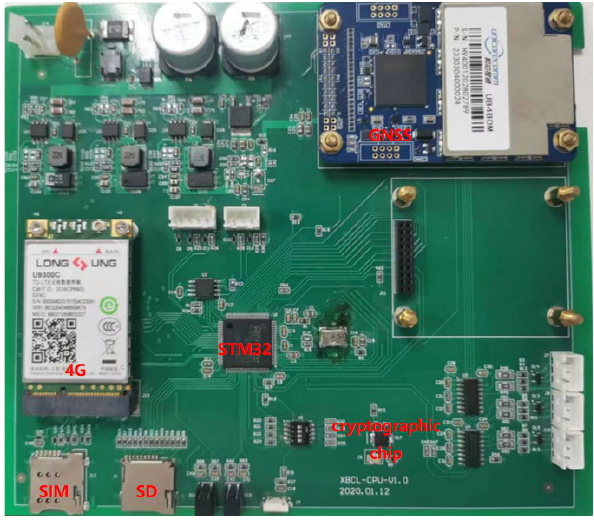
Figure 5. GNSS development board integrated with cryptographic module.